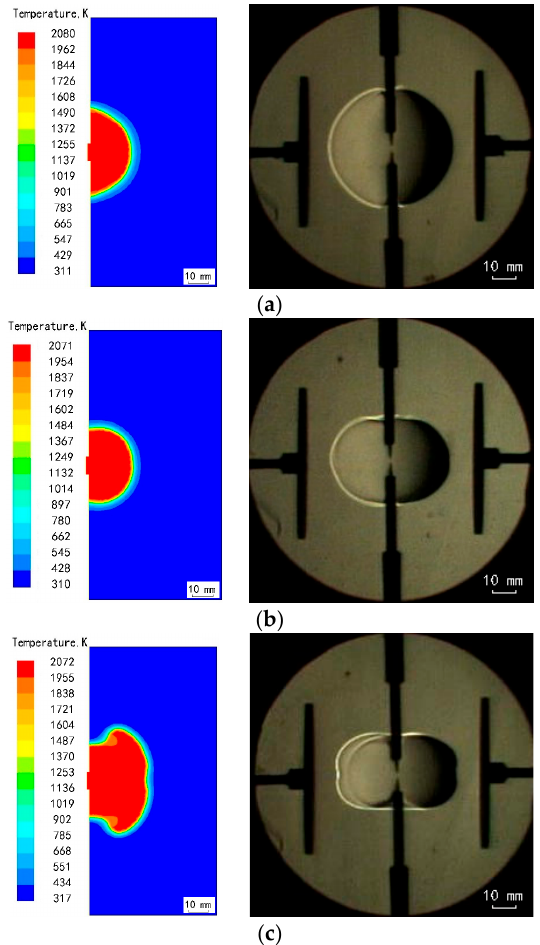
Figure 5. Flame shape in simulation and experimental Schlieren images: ( a ) 0 kV, 45 ms; ( b ) − 2.5 kV, 38 ms; and ( c ) − 5 kV, 34 ms.